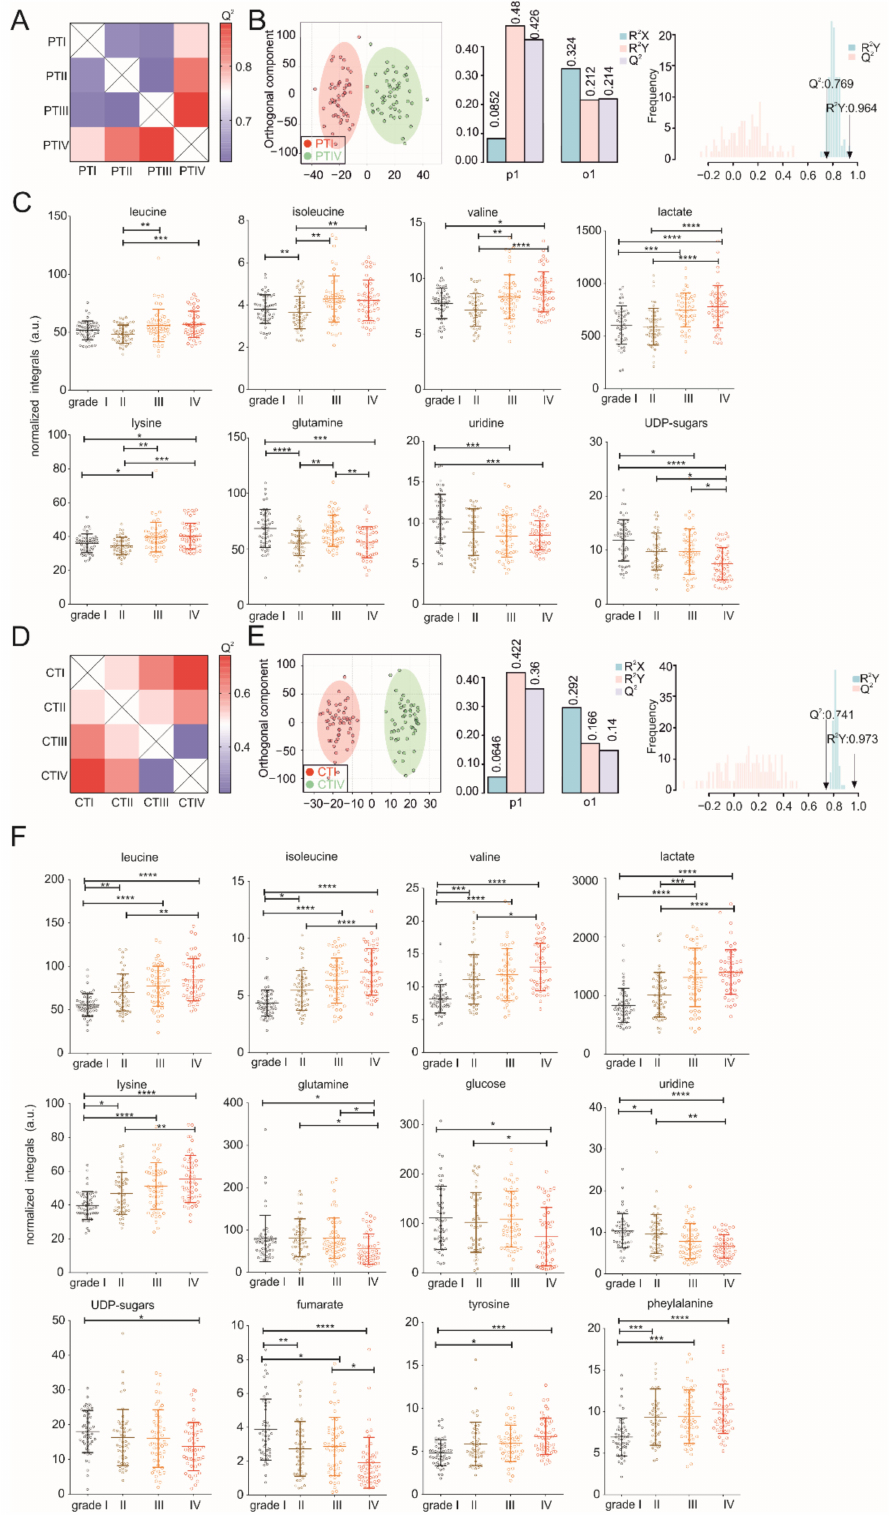
Figure 4. NMR metabolomics analysis of peritumoral and cancer tissue samples at different stages. ( A ) Heatmap